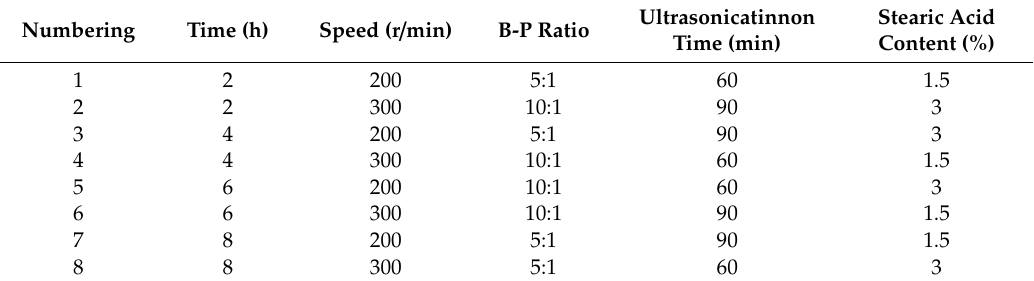
Table 1. Orthogonal distribution of the fabrication parameters.